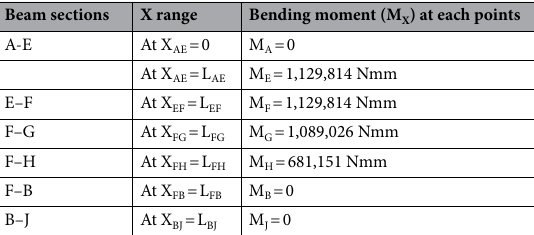
Table 4. Calculated parameter values based on Table 3